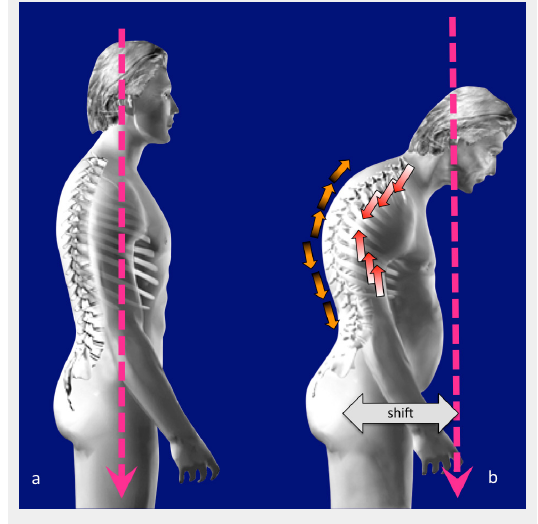
Loss of posture due to vertebral factures: The centre of gravity (pink) is in line with the hip joint in a balanced spine (a). Due to vertebral fractures increased kyphosis occurs and the centre of gravity is shifting forward, throwing the spine out of balance (b). This leads to higher compression loads on the vertebrae (red arrows) and higher strain on the back muscles (orange